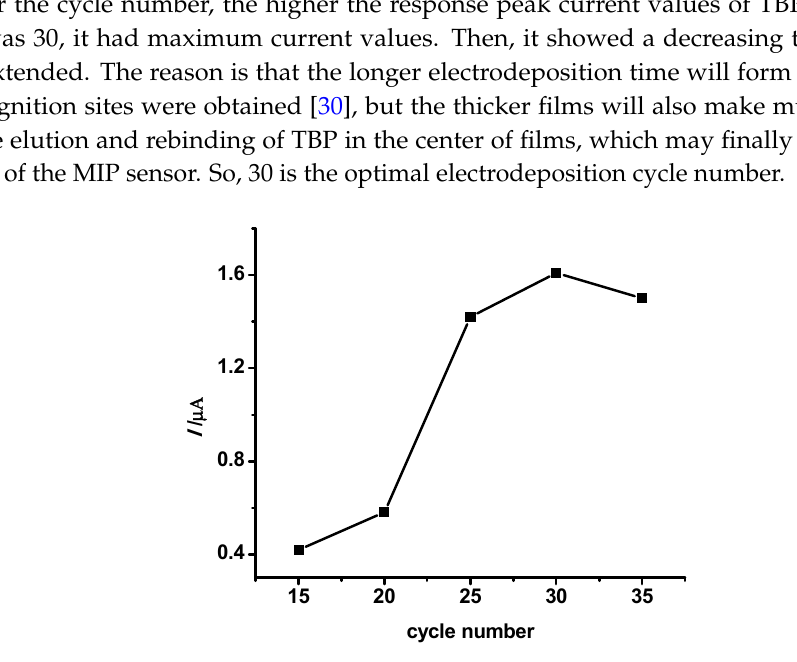
Figure 2. The response performance of molecular imprinting polymers (MIPs)/Au obtained by different cycle number in 5.0 × 10 − 6 mol·L − 1 TBP (each point is representative of only one data point).